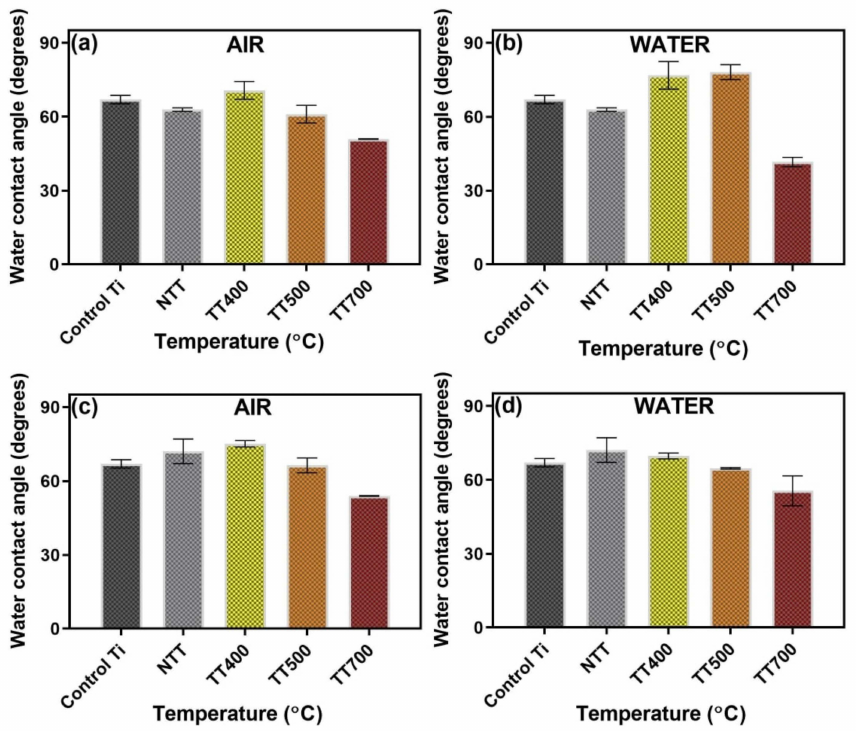
Figure 12. The values of the contact angle obtained in the case of control (Ti), NTT LiC ( a , b ) and LiP ( c , d ) coatings, and of those subjected to post-deposition thermal treatments (at different temperatures), in air ( a , c ) and water-vapor ( b , d ) ambient. Test liquid: